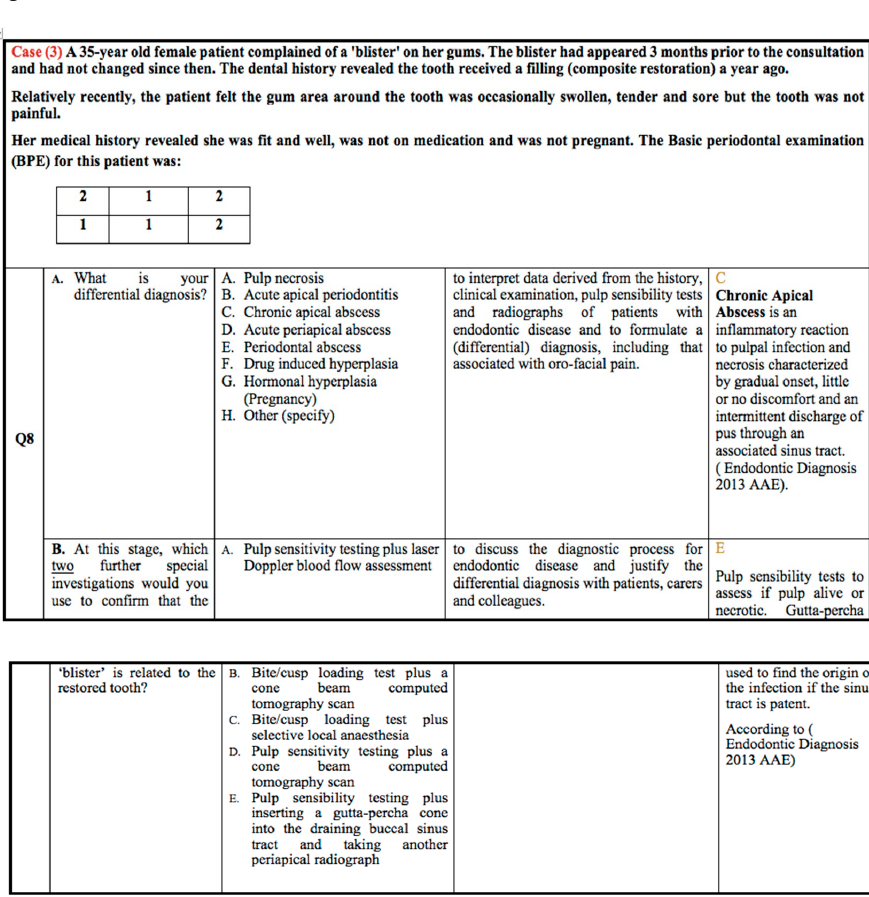
Figure 3. Clinical case scenario 3.